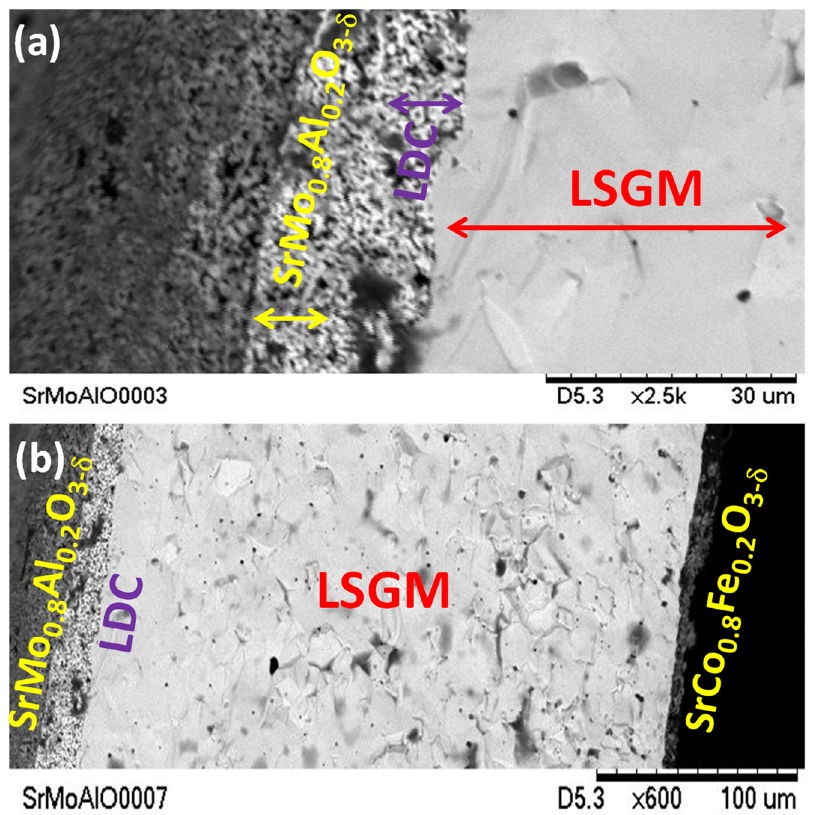
Figure 11. SEM micrographs of ( a ) SrMo 0.8 Al 0.2 O 3 − δ sample showing the porous anode and buffer layers deposited on one side of dense LSGM electrolyte and ( b ) interface SMAO/LDC/LSGM/SCFO after the single cell test.